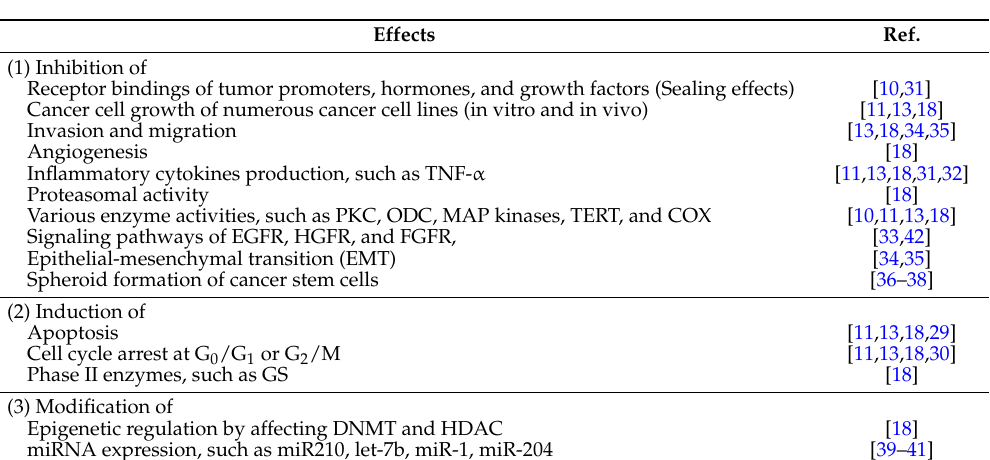
Table 2. Multifunctional effects of green tea